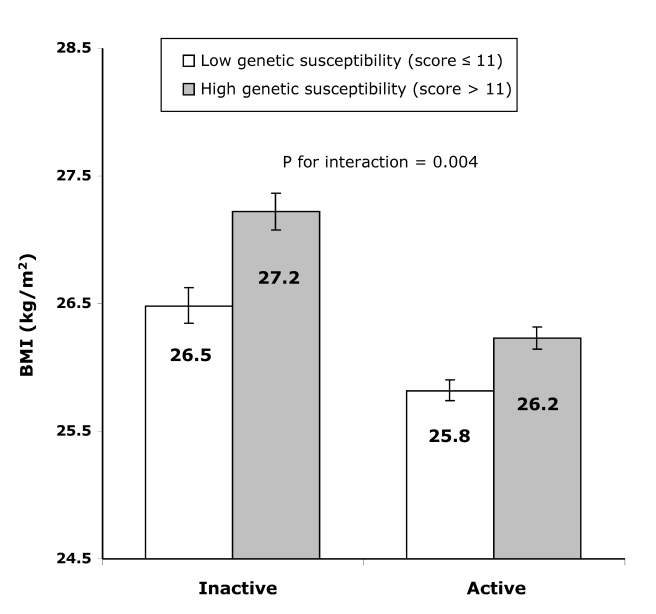
Difference in least square means of BMI between the high (>11 BMI-increasing alleles) and the low (≤11 BMI-increasing alleles) genetic susceptibility groups in the combined active group and the inactive group.Error bars show 95% CIs.